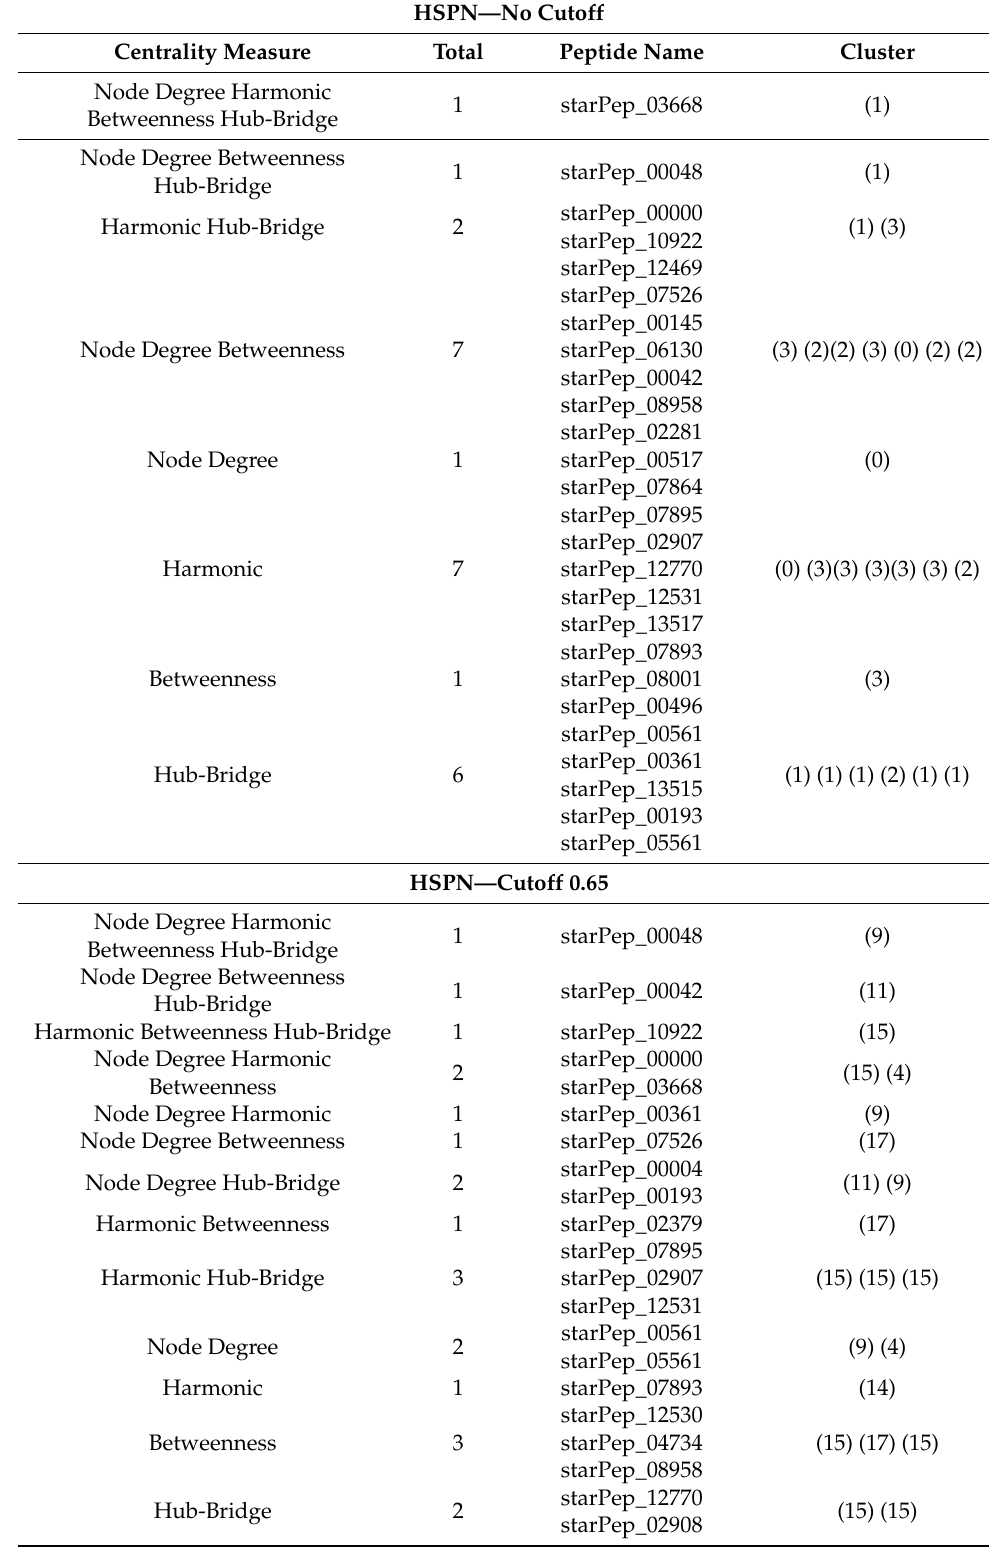
Table 1. Common and singular peptides from the ten top-ranked ABFPs by four, three, two and one centrality measure (node degree, harmonic, betweenness and hub-bridge centralities). The cluster number for each peptide at each HSPN is